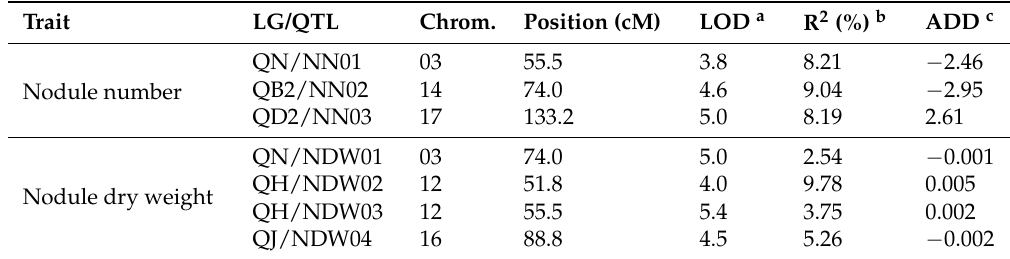
Table 2. Chromosomal localization of conditional QTLs for nodule-related traits.